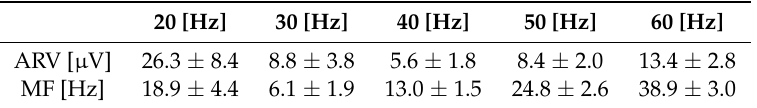
Table 1. Root mean square error (RMSE) in average rectified value (ARV) and mean frequency (MF) for high-pass filtering (HP) with different cutoffs.